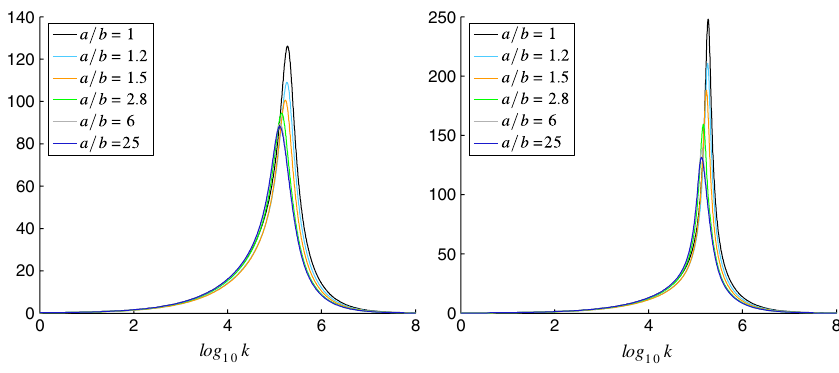
k ( k in m (cid:1) 1 ) obtained using the AC conductivity model for aluminum (a) and copper FIG. 4. (Color) Longitudinal impedance vs log 10 (b), semiaxis b (cid:4) 3 mm , and with several aspect ratio values a=b